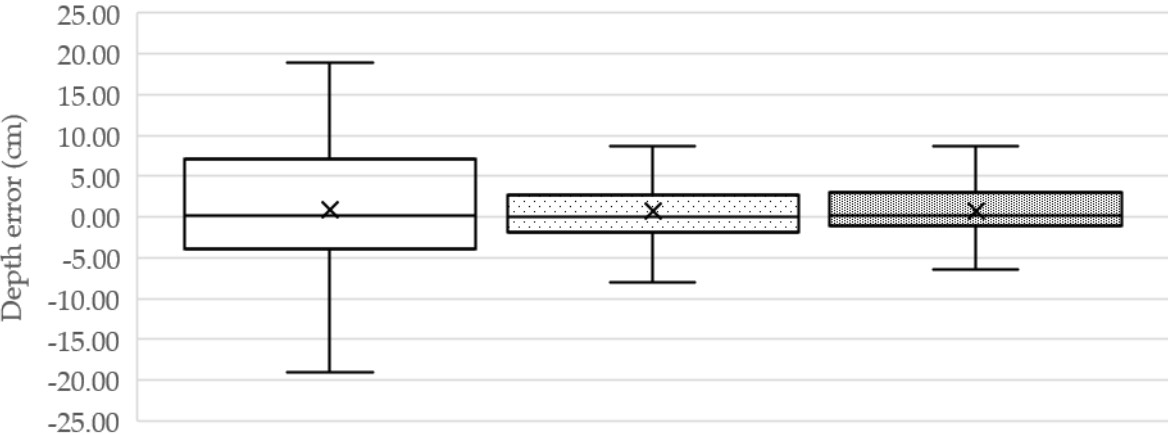
Figure 10. Box − plot comparison of Tilapia Depth Estimation error of LR, RFR, and SVR methods.